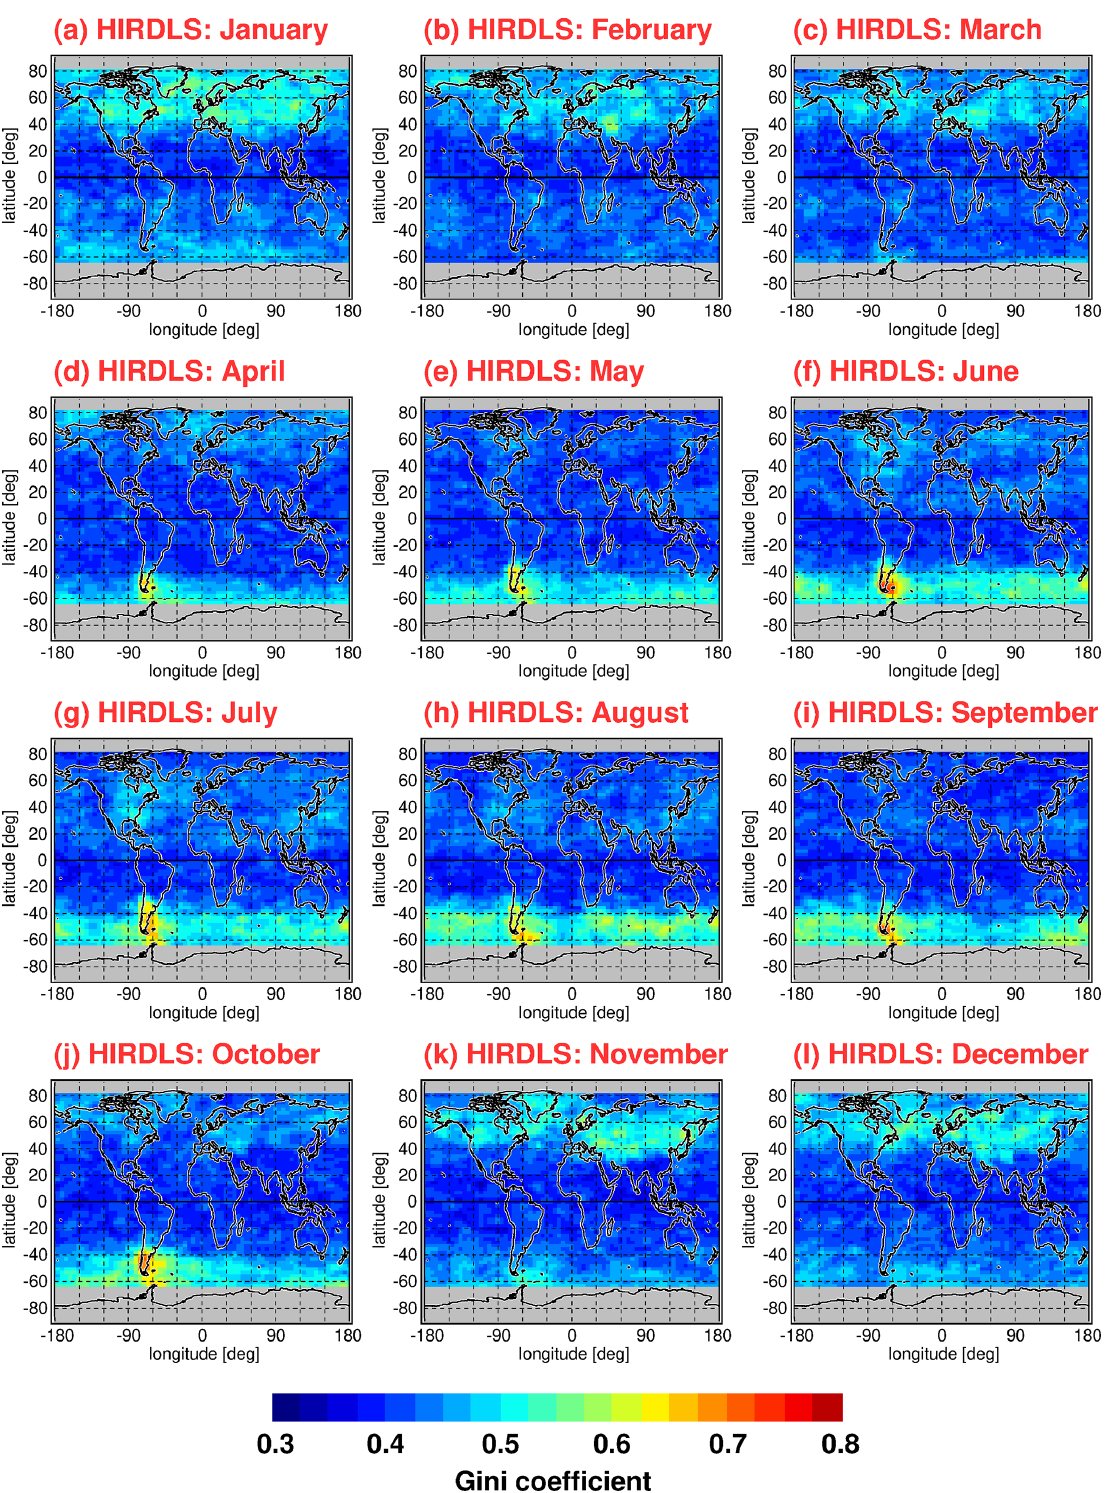
Figure 11. Global distributions of the Gini coefficients for HIRDLS gravity wave potential energies at 30km altitude for each calendar month. Values shown are multiyear means of monthly values determined in overlapping 5 ◦ × 15 ◦ (latitude × longitude) grid boxes. Single E pot values were normalized by the monthly median distribution before calculating the Gini coefficients. The period used for averaging is March 2005 to February 2008.